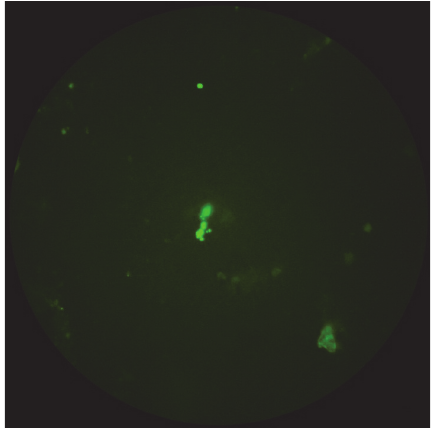
Figure 1: P. jiroveci in BAL